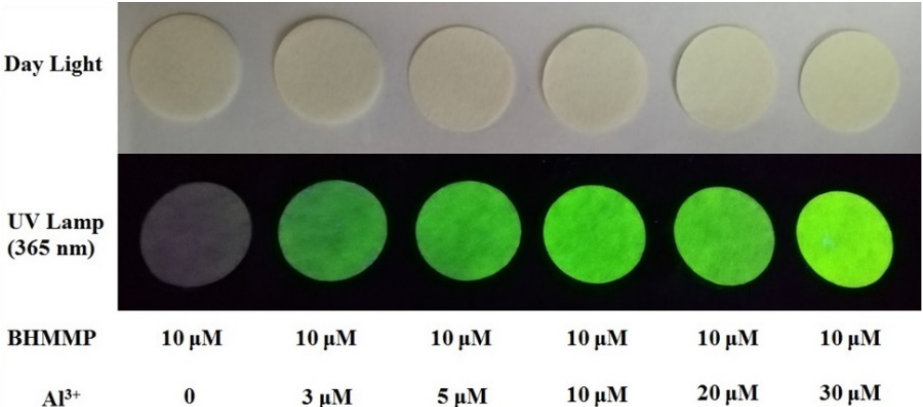
Figure 10. Photographic image of different concentrations of Al 3+ by BHMMP (10 µ M) on test strip by daylight and UV light.